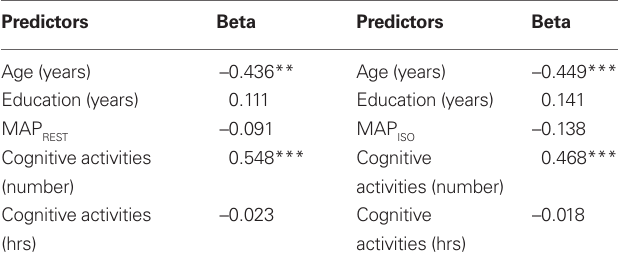
Table 5 | Summary of final significant model for prediction of global cognitive score when MAP variables are included.